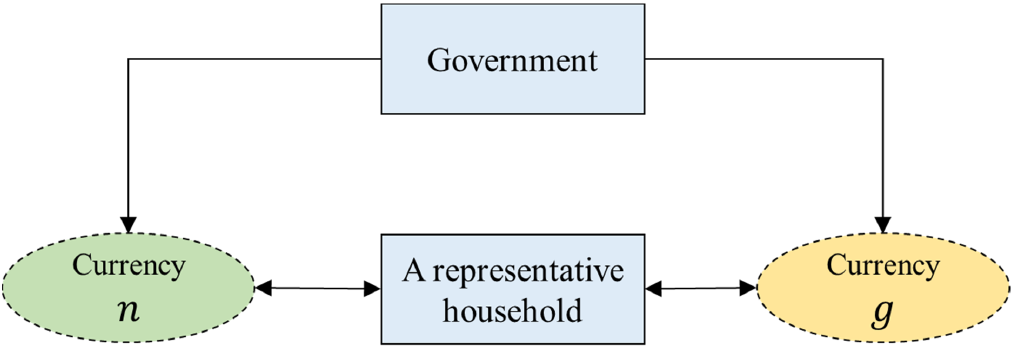
Figure 2. The government and a representative household involved in a national currency 𝑛 and a global currency 𝑔 .